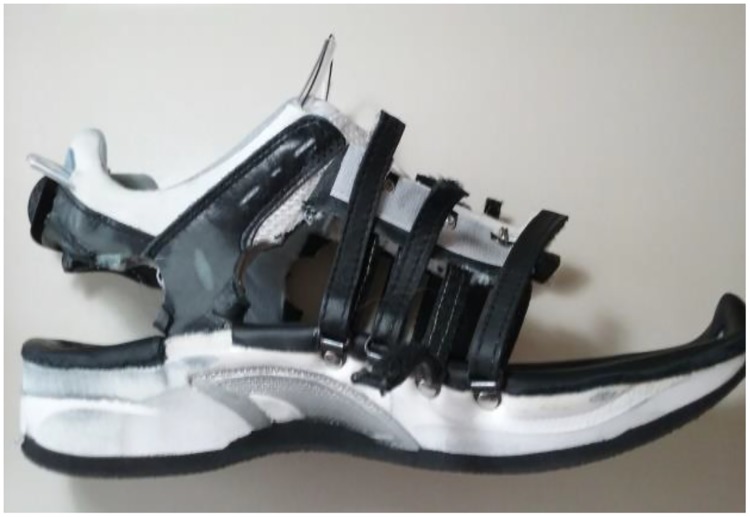
Experimental shoe.